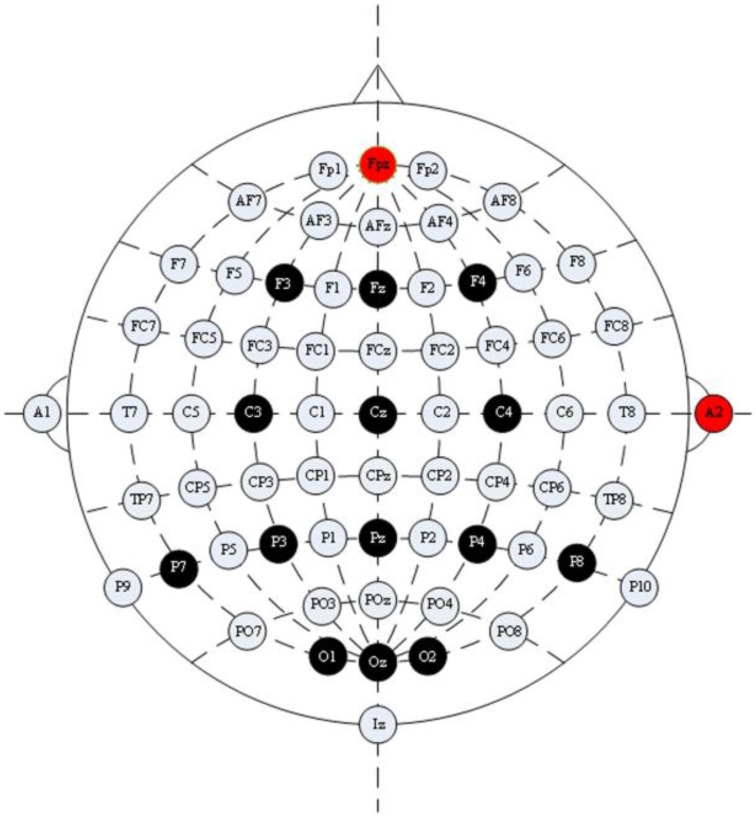
Configuration of electrode positions. The electrode positions used in our experiment were F3, F4, Fz, C3, C4, Cz, P7, P3, Pz, P4, P8, O1, O2, and Oz; Fpz was used as the ground electrode position; A2 was used as the reference electrode position.